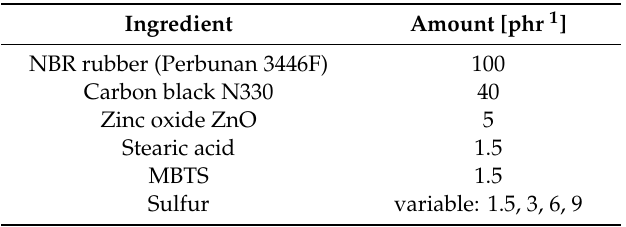
Table 1. Ingredients of the examined